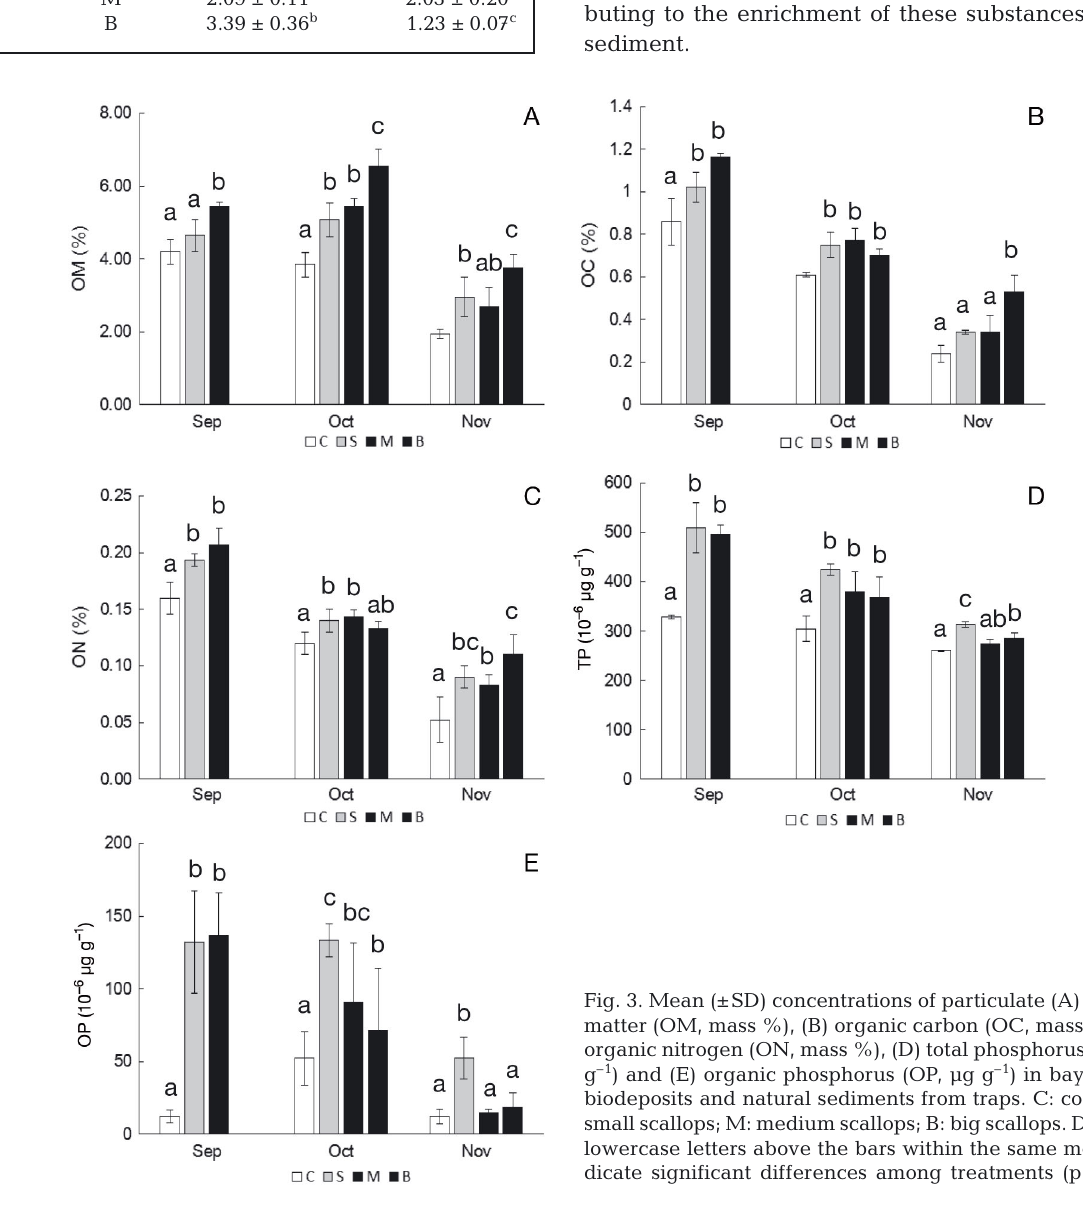
Fig. 3. Mean (±SD) concentrations of particulate (A) organic matter (OM, mass %), (B) organic carbon (OC, mass %), (C) organic nitrogen (ON, mass %), (D) total phosphorus (TP, µg g –1 ) and (E) organic phosphorus (OP, µg g –1 ) in bay scallop biodeposits and natural sediments from traps. C: control; S: small scallops; M: medium scallops; B: big scallops. Different lowercase letters above the bars within the same month in- dicate significant differences among treatments (p <